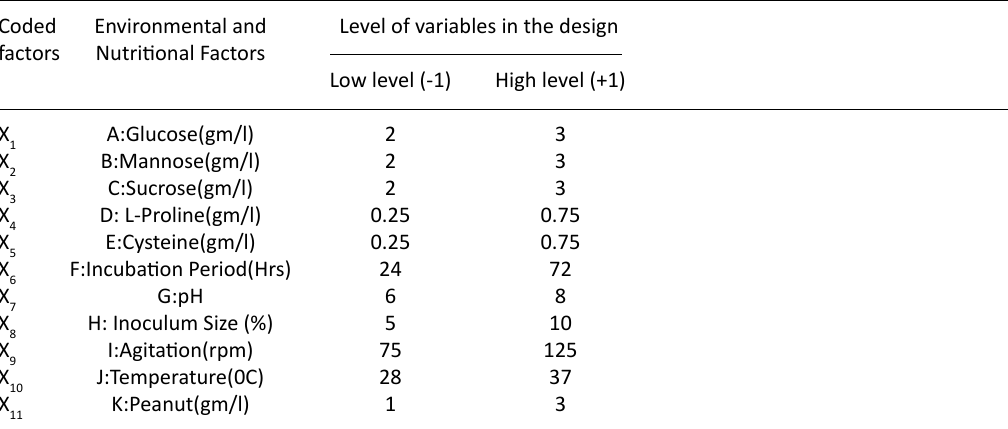
Table 1. Design of variables and coding selection of Nutritional components and Environmental parameters of the medium for the production of Prodigiosin using Serratia marcescens A2 Coded Environmental and Level of variables in the